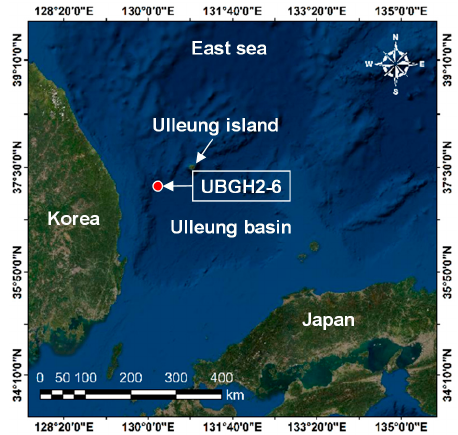
Figure 1. Location of the Ulleung Basin Gas Hydrate drilling expedition 2 (UBGH2-6) (modified from [8]).